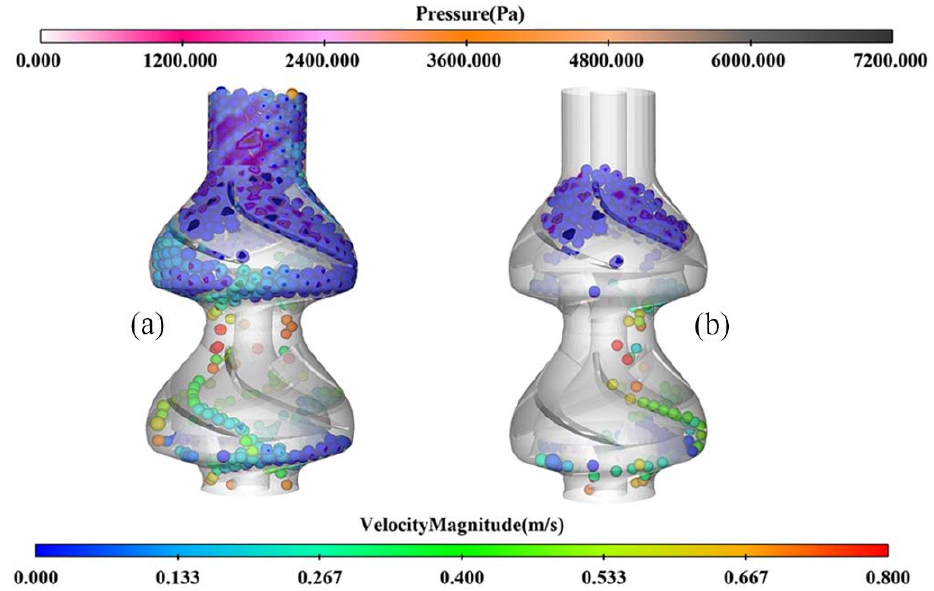
Figure 12. Movement and accumulation of 30–40 mm particles in the pump: ( a ) 30–40 mm particles at 10 s simulation; ( b ) 30–40 mm particles at 30 s simulation.